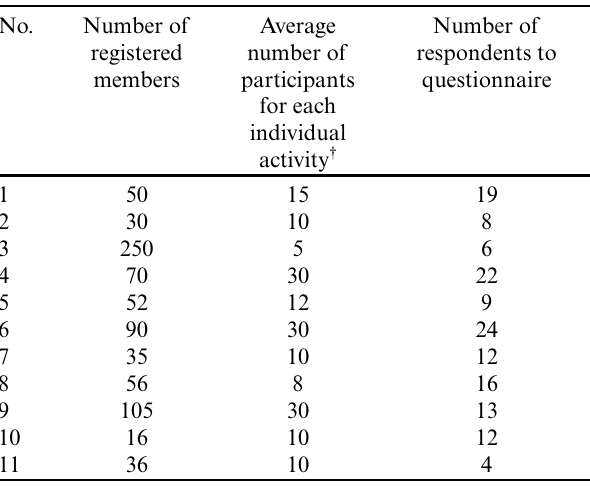
Table 2 . Number of group members: registered, average,